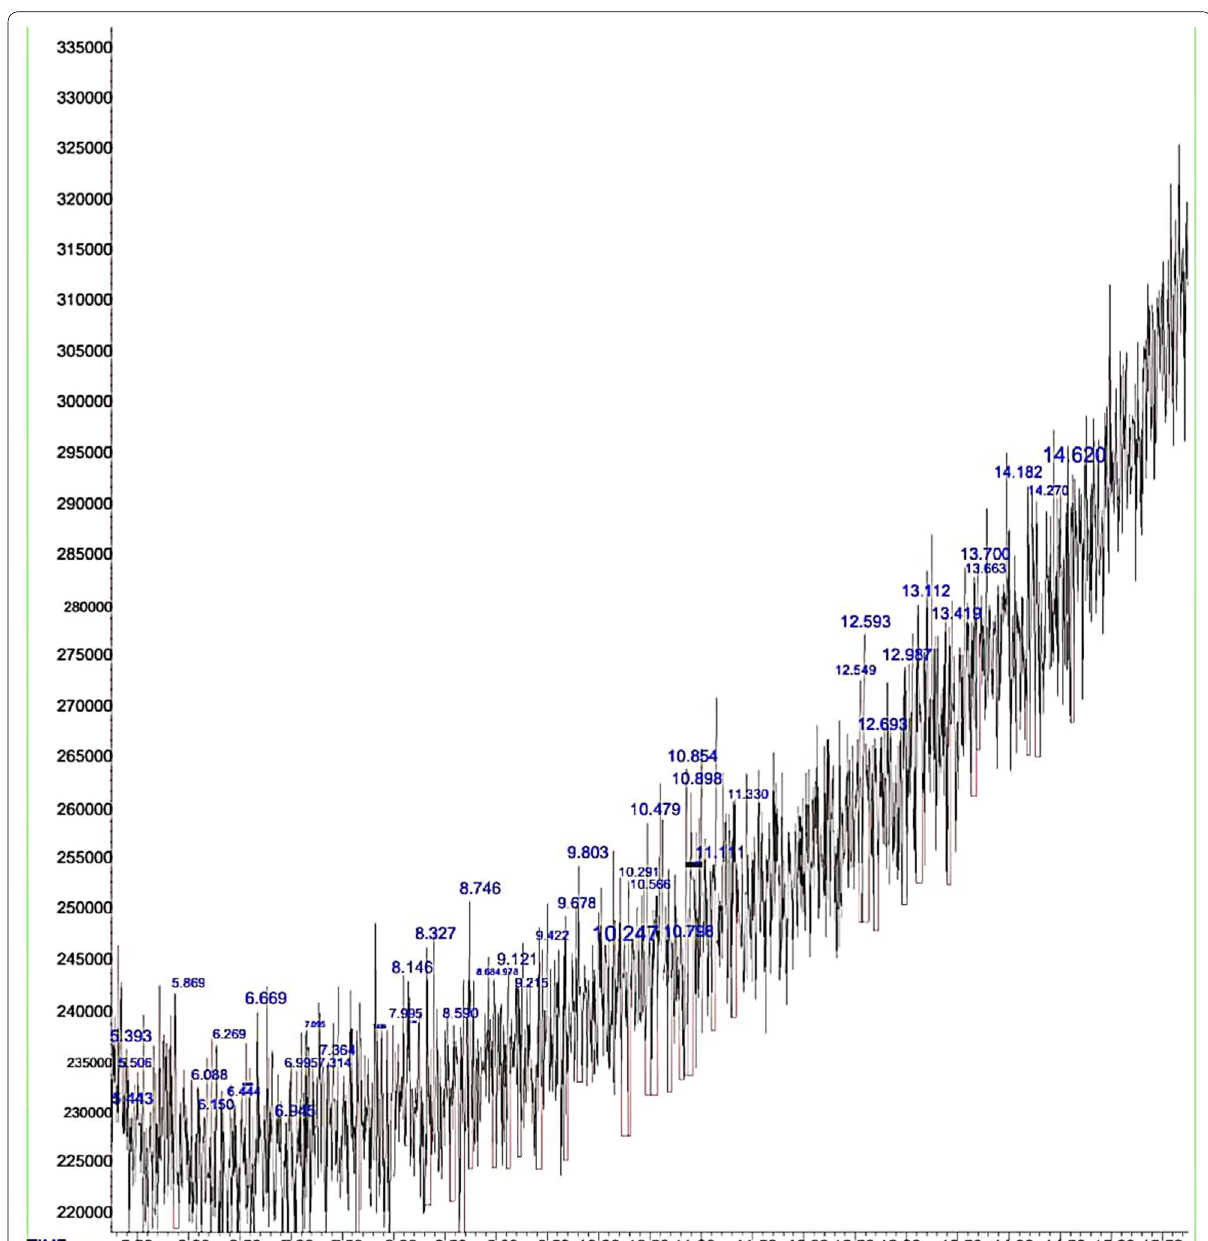
Fig. 1 GCMS Analysis Spectral of Methanolic Leaf Extract of Eucalyptus globulus